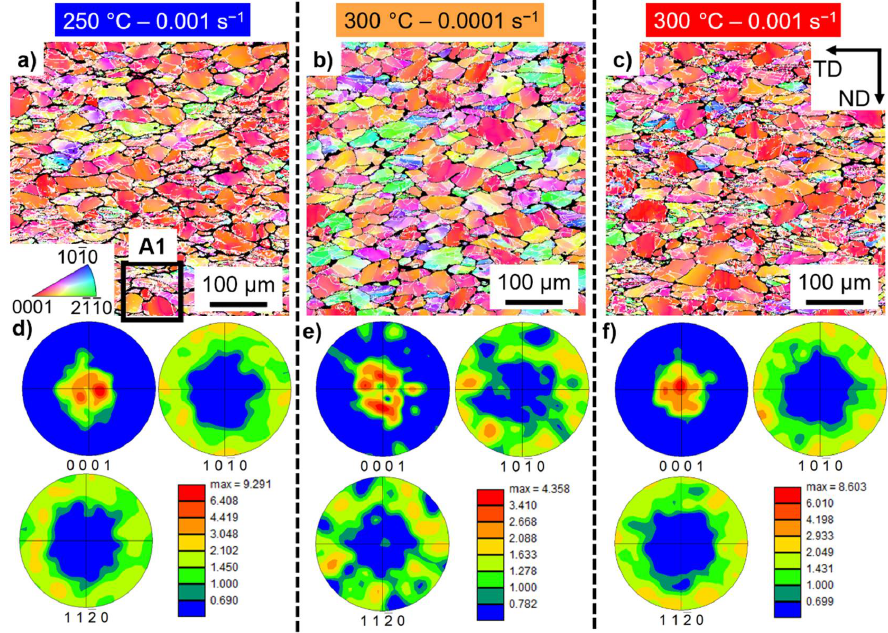
Figure 4. Electron backscattered diffraction results for the ZK40-CaO alloy: ( a – c ) inverse pole figure maps and ( e , f ) pole figures. The tested conditions: ( a , d ) 250 ◦ C and 0.001 s − 1 ; ( b , e ) 300 ◦ C and 0.0001 s − 1 ; ( c , f ) 300 ◦ C and 0.001 s − 1 . Only α -Mg is indexed. Non-indexed regions are highly deformed regions or intermetallic compounds. White and black lines indicate low and high angle grain boundaries, respectively. Area A1 is shown in Figure 14. ND and TD indicate the compression and transversal directions,